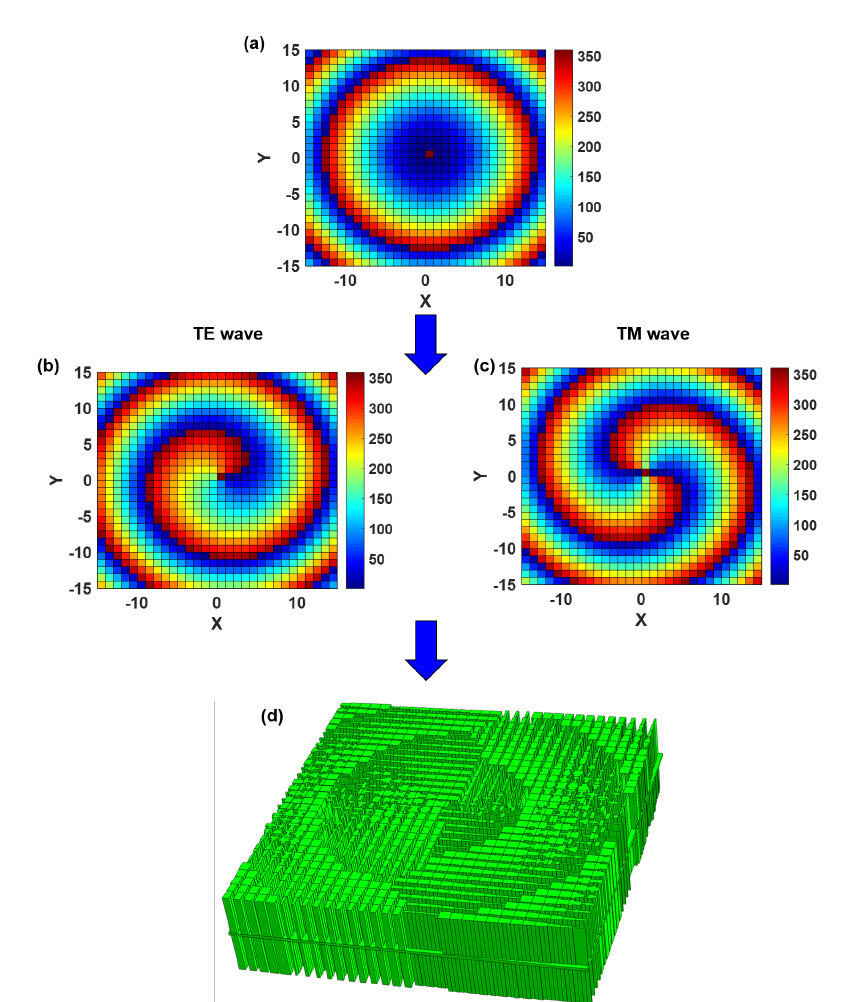
Figure 6. The calculation compensation phase and process on the dielectric lens. (a) Phase compen- sated for feed spherical. (b) Compensation phase distribution required to generate l = vortex wave after TE wave irradiation. (c) Compensation phase distribution required to generate l = + 2 mode vortex wave after TE wave irradiation. (d) Dielectric lens structures generated by machine learning.